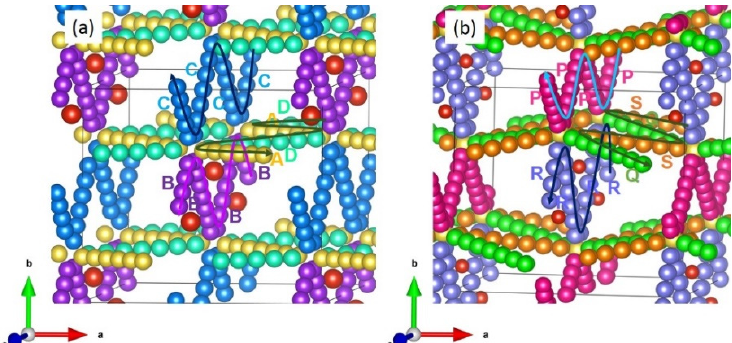
5 of 12 Figure 2. Intrinsic defect energies in LiVSi 2 O 6 and NaVSi 2 O 6 . 3.3. Diffusion of Li and Na Ions Here, we calculate the diffusion of Li + and Na + ions. High ionic conductivity is one of the key features of a cathode material, because it determines the performance of batteries. The current methodology has the ability to determine the diffusion pathways together with activation energies. In previous simulations, many oxide materials have been as- sessed and the results from those simulations have been supportive in interpreting the experimental data [57–59]. Four different possible Li local hops (A, B, C and D) were identified in LiVSi 2 O 6 (see Figure 3a). Local Li hops together with activation energies are provided in Table 3. Hops A and D formed a long-range Li migration pathway (A → D → A → D) with a zig-zag pat- tern in the ac plane. Activation energies for these hops were 2.47 eV and 4.49 eV, respec- tively, meaning that long-range migration requires an overall activation energy of 4.49 eV. A long-range Li migration pathway consisting of local hop B (B → B → B → B) is observed